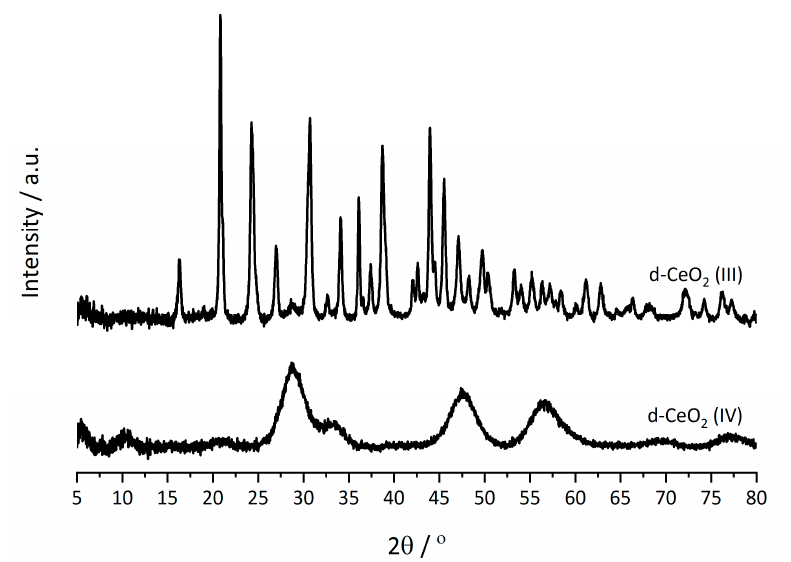
Figure 1. Powder X-ray diffraction patterns of precipitated catalyst precursors prior to calcination.